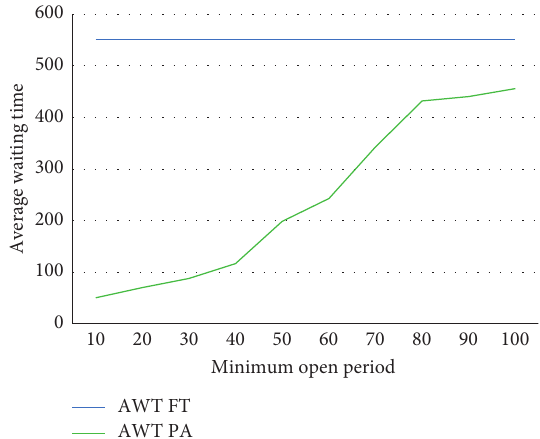
Figure 18: Effect of changing the minimum open period on the average waiting time using FT and PA algorithms.